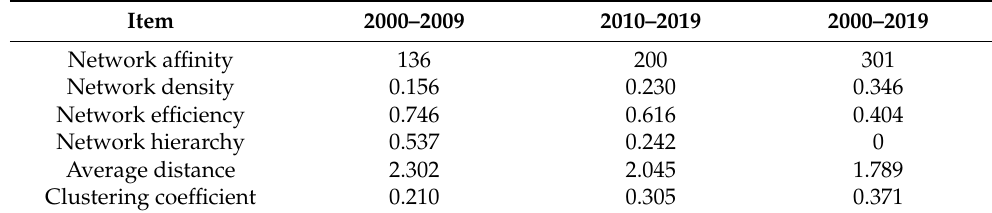
Table 3. Overall characteristics of interprovincial agricultural water use efficiency spatial network.